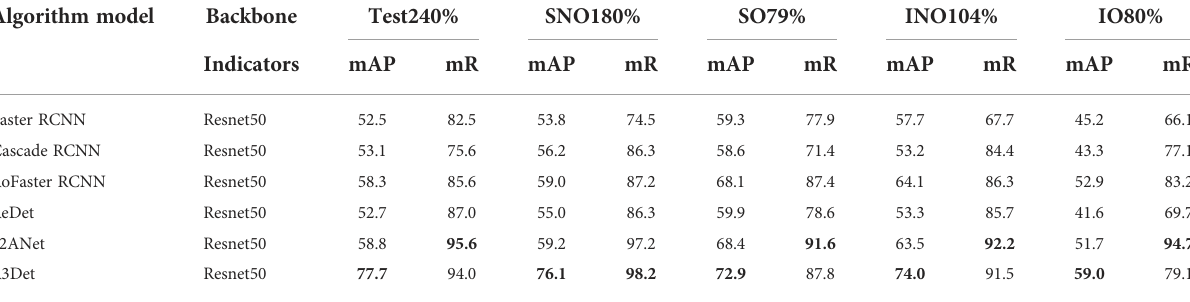
TABLE 4 Comparison of detection results when the input picture is